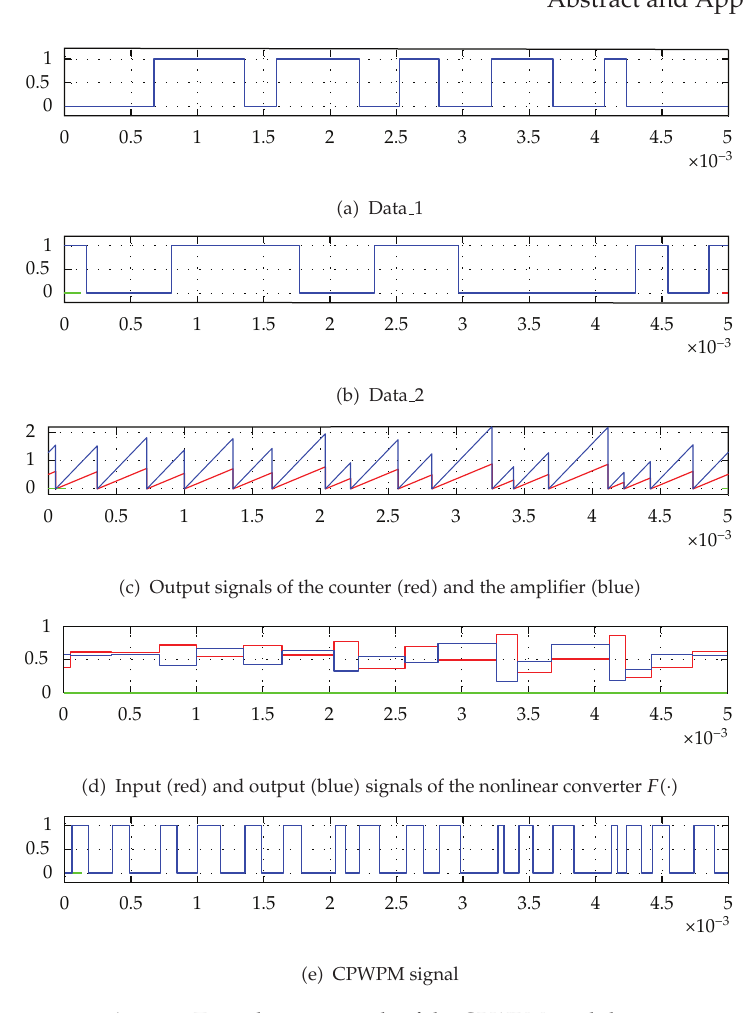
Figure 7: Time-domain signals of the CPWPM